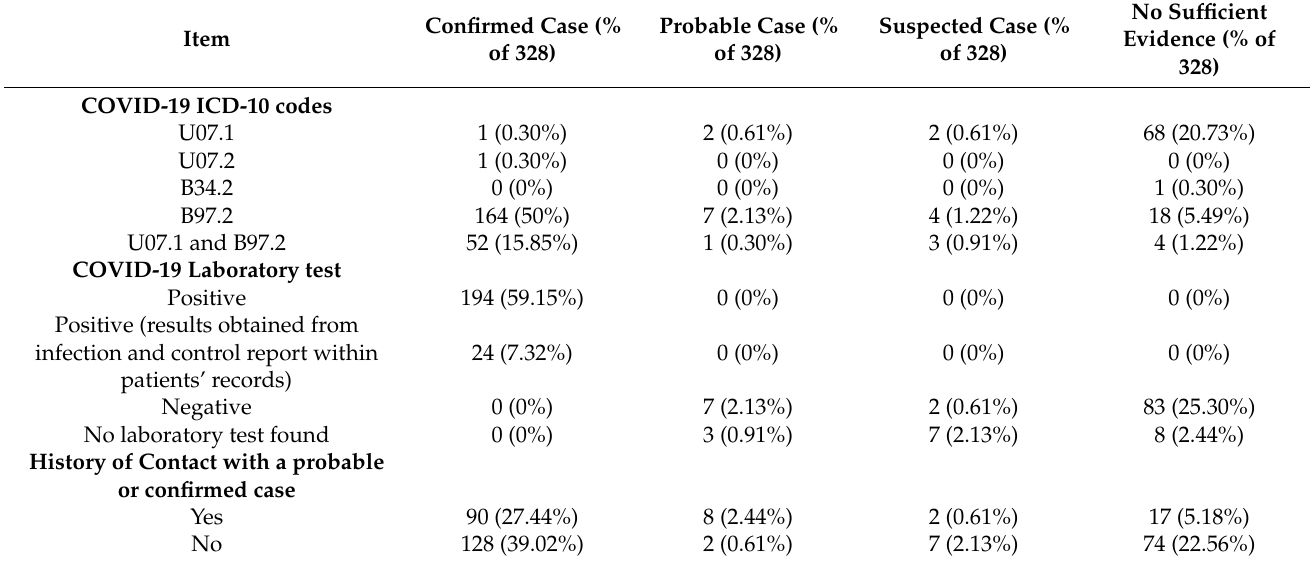
Table 3. Patients’ records description linked to final